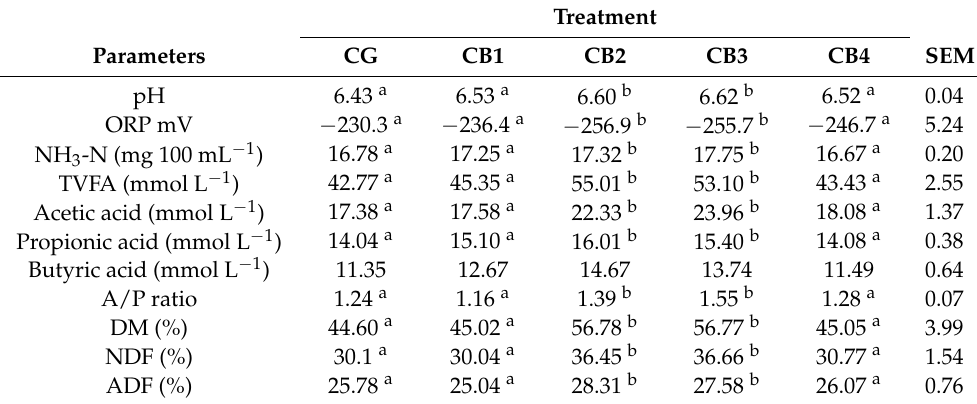
Table 4. Fermentation parameters in rumen cultures with Clostridium butyricum incubation in vitro.